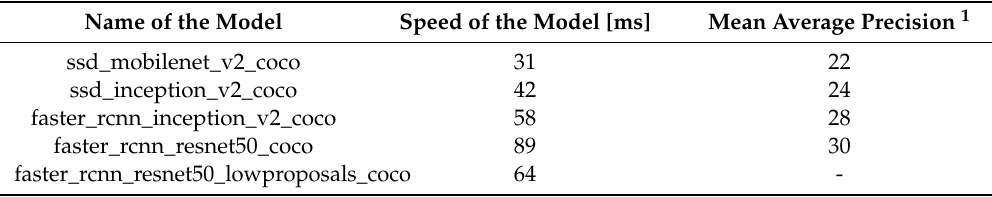
Table 2. Pre-trained TensorFlow